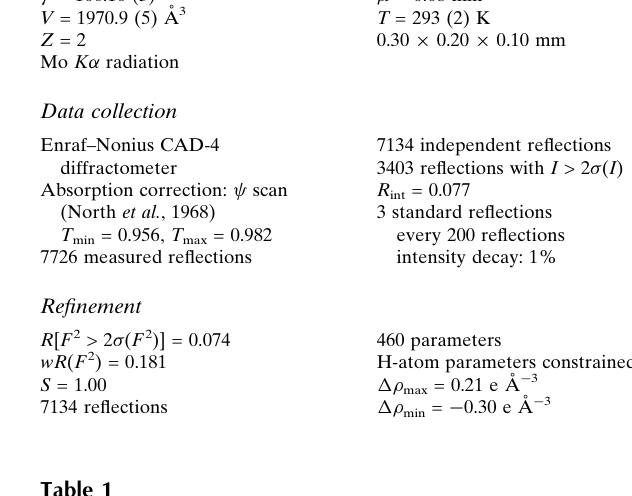
Hydrogen-bond geometry (A˚ , (cid:2)